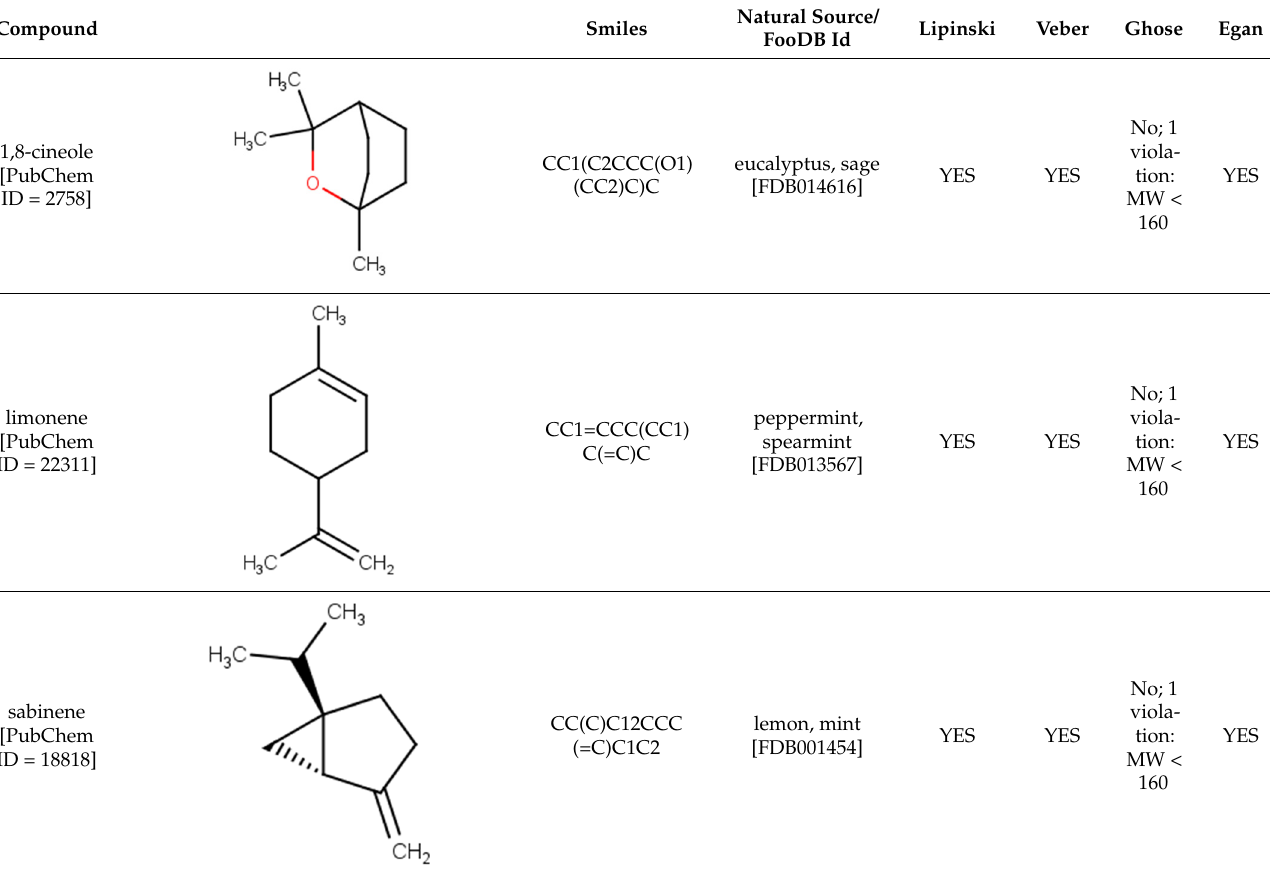
Table 2. The name of natural compounds and PubChem ID, 2D structure, SMILES [56], natural source, compound FooDB ID [30], and the druglikness features [47].